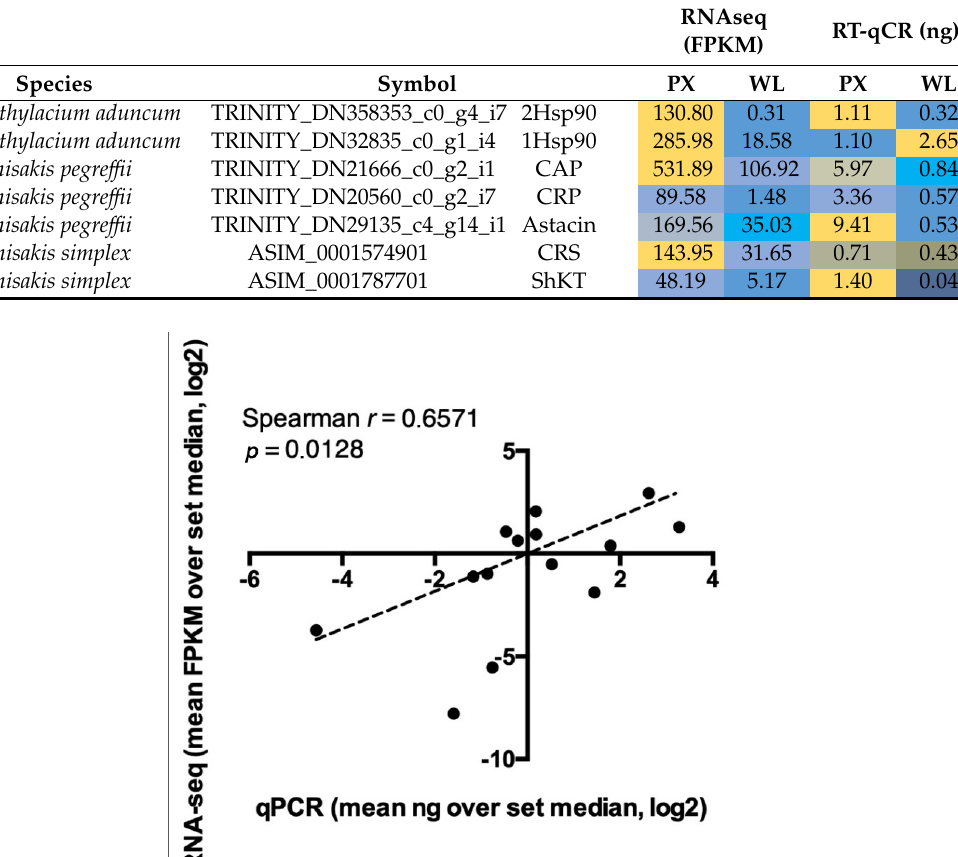
Figure 4. RTqPCR validation of transcript abundance . Graphs summarize the relative quantification obtained by Real Time PCR of transcripts selected among the PX enriched cluster in the three taxa. Representative bar plots, with standard errors indicated, are shown: ( a ). Hsp90 isoform 2 in HA; ( b ). astacin in AP; ( c ). Shk toxin in AS. Transcript abundance was investigated in dissected pharyngeal region (PX), in whole larvae (WL) and in the remaining carcasses from the dissections (CARC).